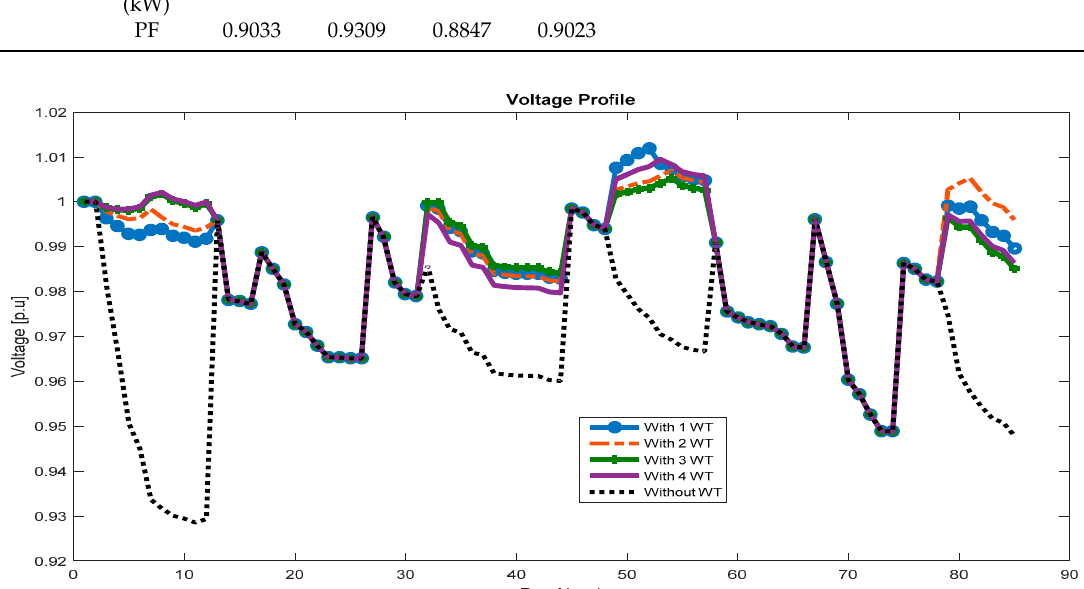
Figure 6. 84-bus grid voltage profile before and after installing the turbines with respect to constraints.